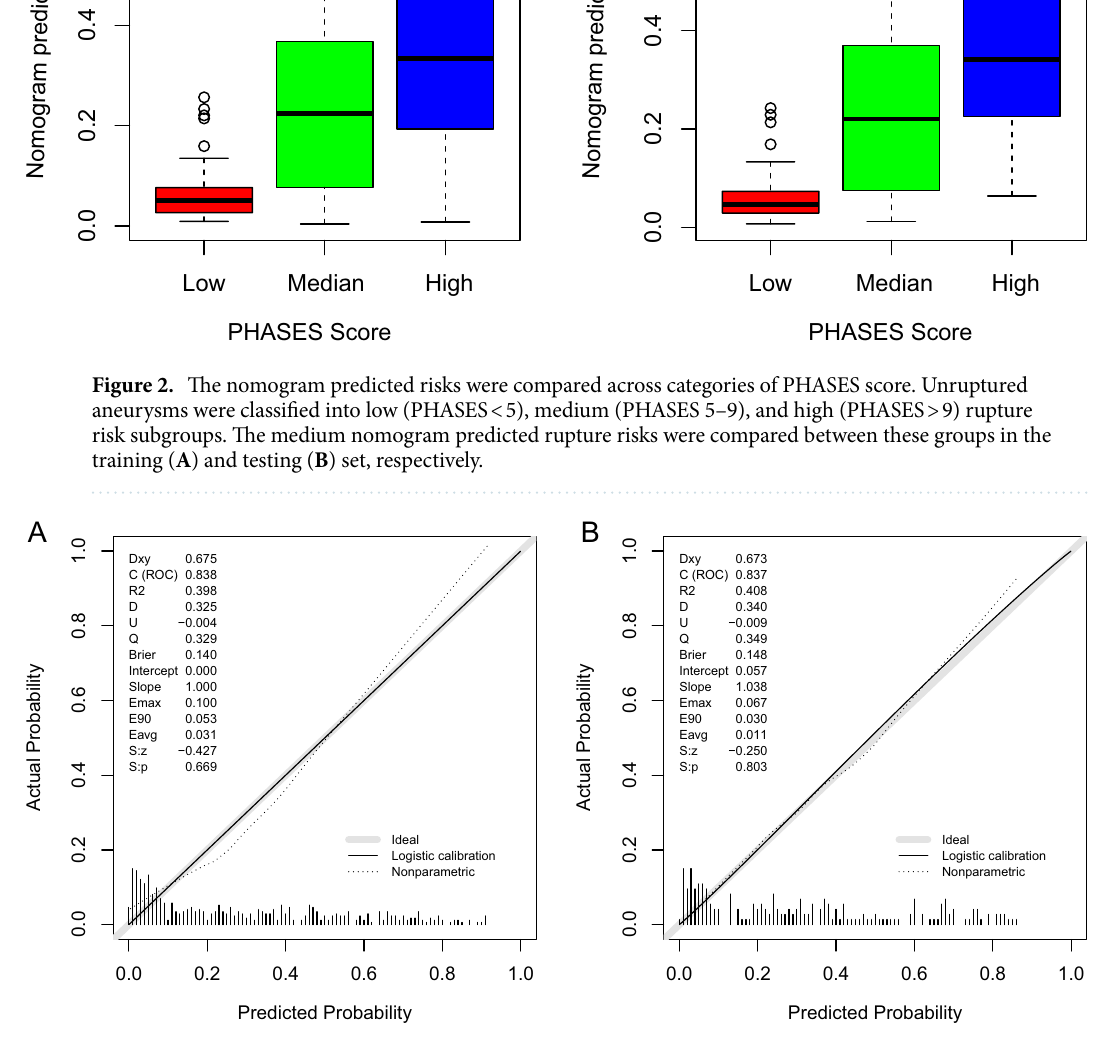
Figure 3. Calibration of the nomogram. The nomogram predicted rupture risks demonstrated high consistency with the actual rupture status in the training ( A , P = 0.669) and testing ( B , P = 0.803)